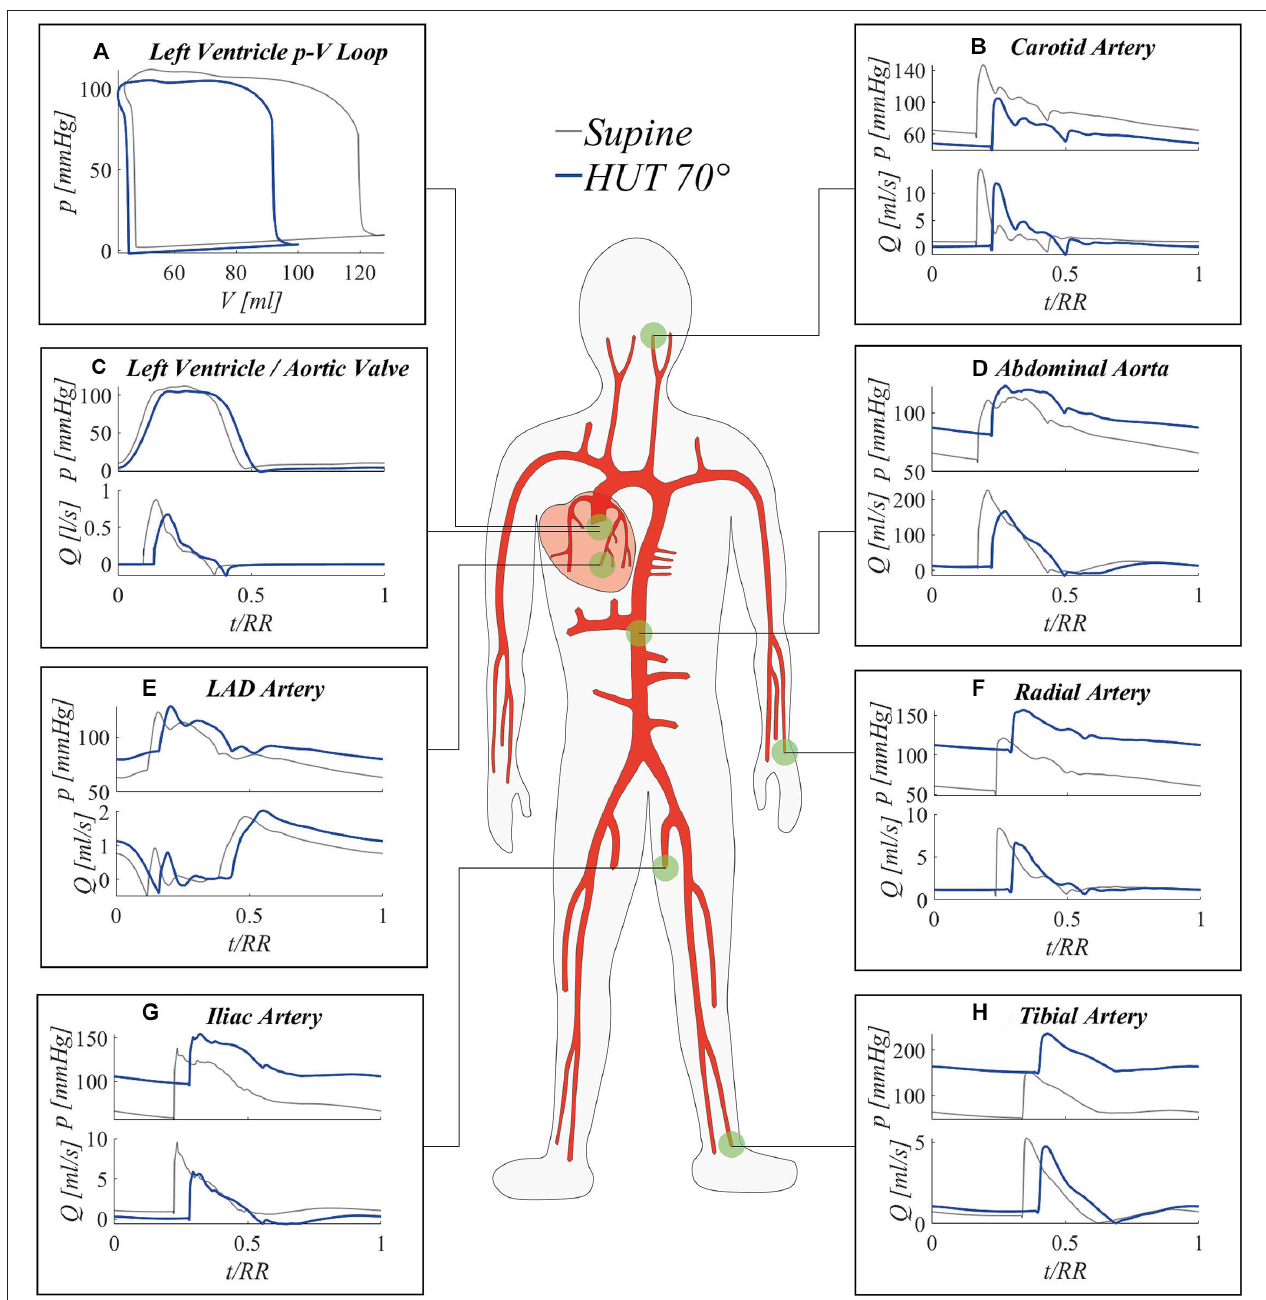
FIGURE 5 | Simulated steady-state results at 70 ◦ HUT (blue) and in the supine position (gray): (A) left ventricle pV loop; pressure (top) and flow rate (bottom) signals at left ventricle (C) , and at representative sites along the arterial tree (B,D–H) .